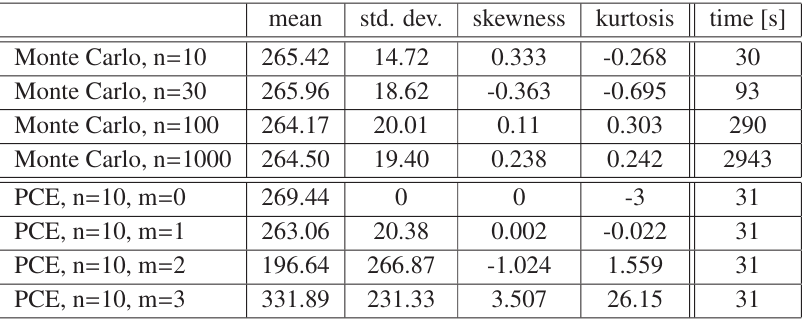
Table 1: Statistical measures of results with simulation time mean std.